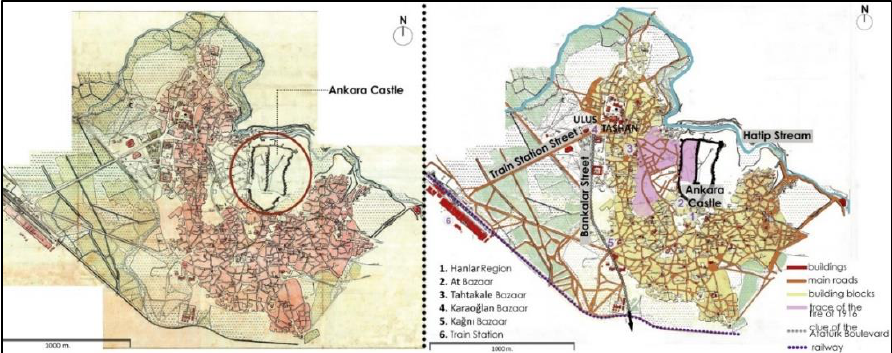
Figure 7 The 1924 map & its spatial